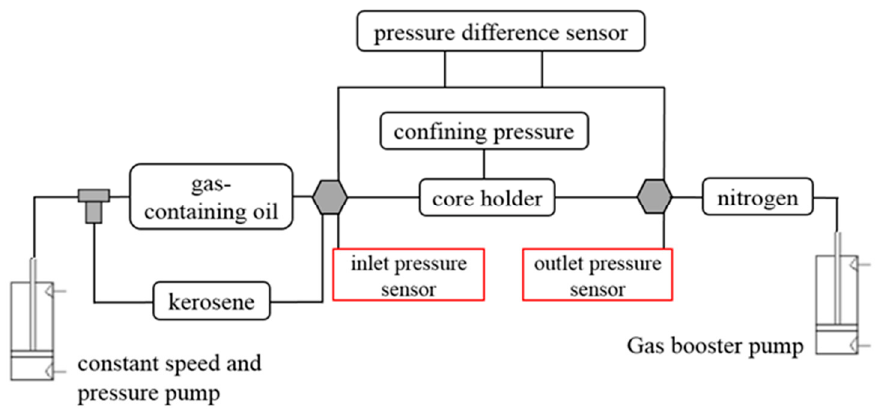
Figure 3. Flowchart of the resistance gradient experiment.